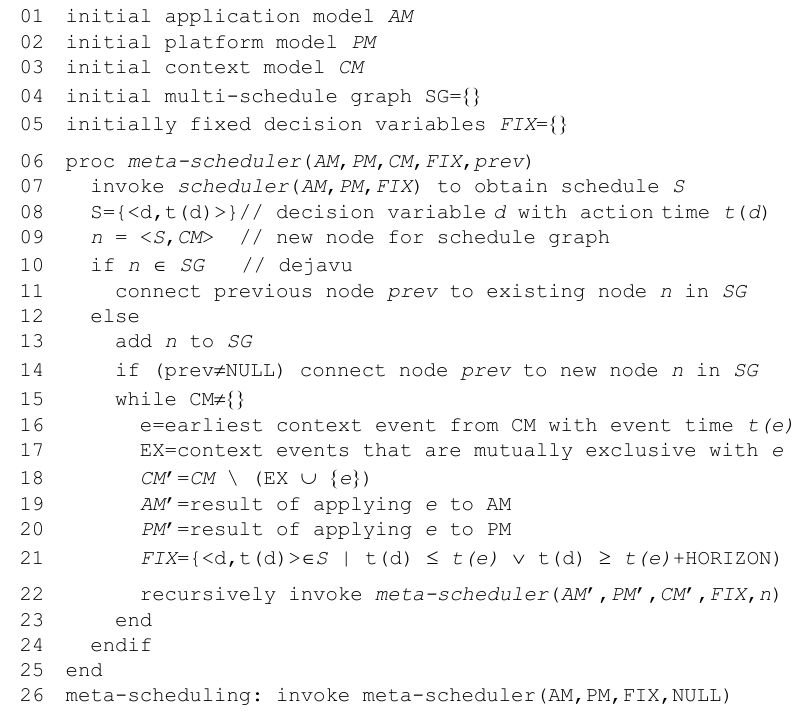
Figure 4. Meta-scheduling